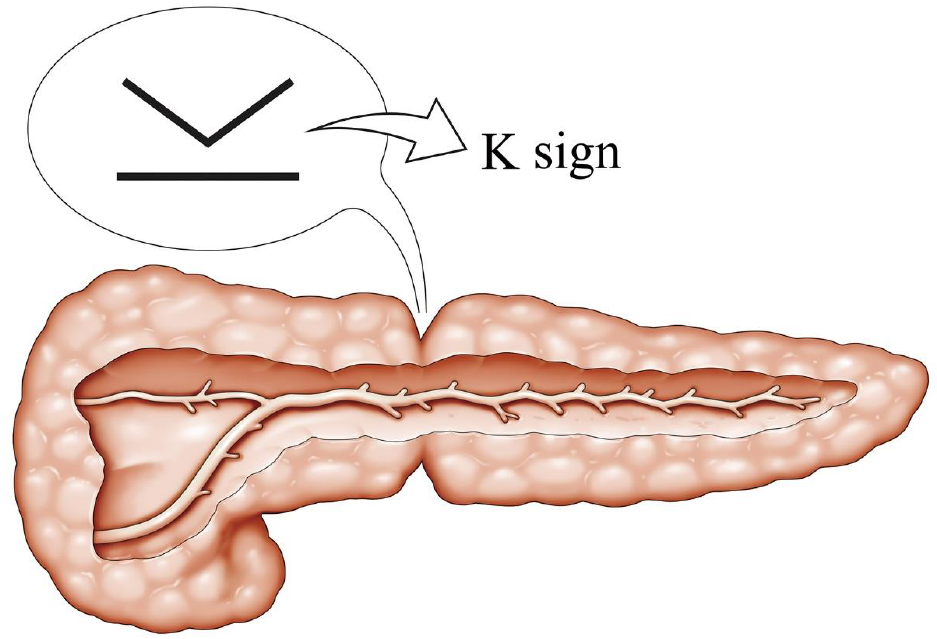
Figure 2. Illustration and definition of K-sign. K-sign means a localized constriction of the pancreatic parenchyma. It looks “K” on axial CT image.